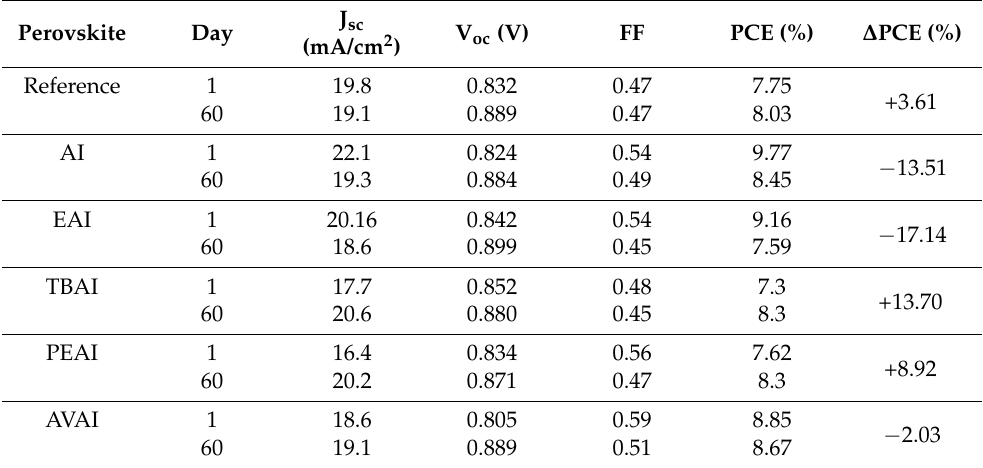
Figure 15. Comparative current density–voltage curves of the 6 carbon-based solar cells under study, under illumination of 100 mW cm − 2 simulated sun irradiation (1.5 AM) at the first day of their fabrication and after 60 days of shelf life. Table 8. Comparative table of electrical parameters derived from the J-V curves of the C-PSCs under study at the first day of their fabrication and after 60 days of shelf